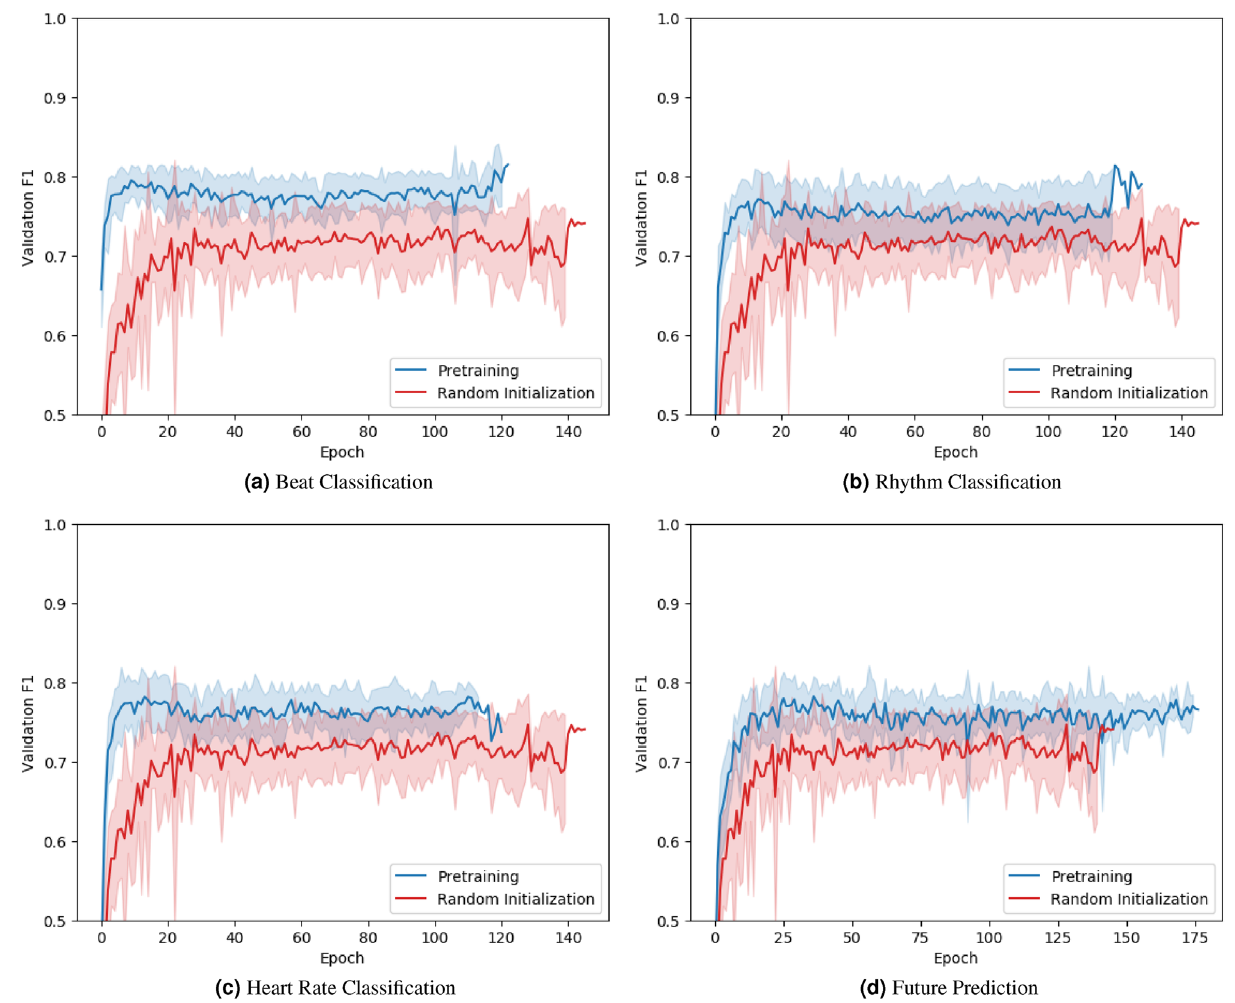
Figure 3. Average macro F 1 on the validation set during finetuning. At each epoch, the average validation score of a selected pretraining method (blue) and random weight initialization (red) is reported. Pretraining improves validation performance on the downstream task and accelerates the